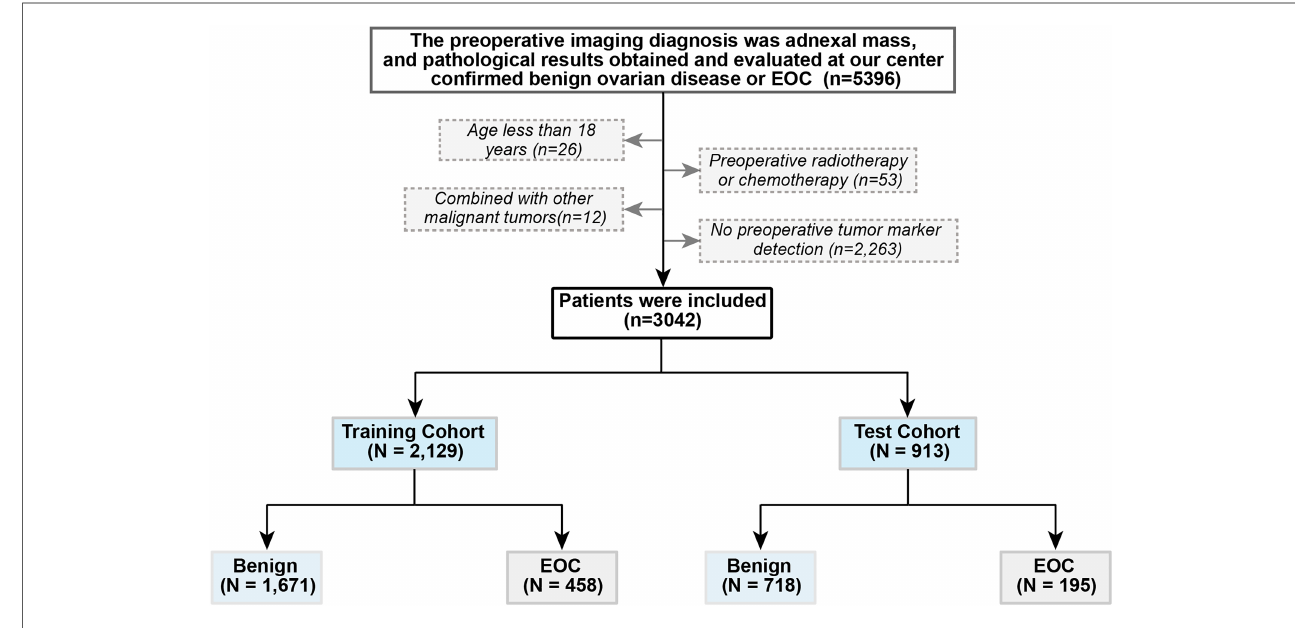
FIGURE 1 Flowchart of patient selection. EOC, epithelial ovarian